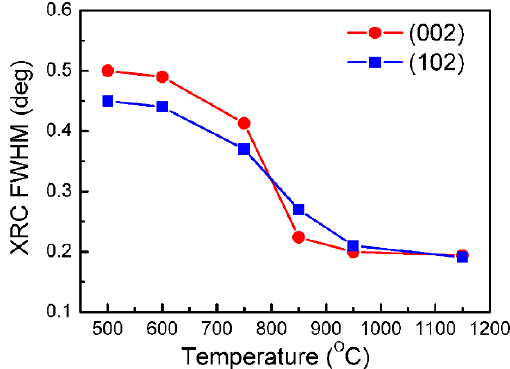
Figure 3. The XRC FWHMs of N-polar GaN with an AlN buffer grown at different temperatures.